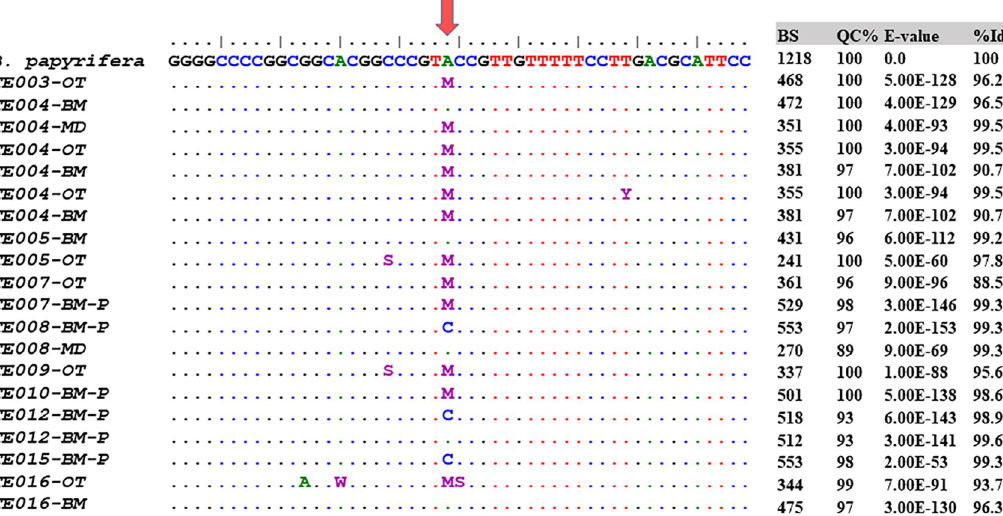
Fig 2. Polymorphisms detected in the ITS-1 sequence of paper mulberry barkcloth textiles. Multiple alignment of 20 selected partial ITS sequences (50 bp) of textile samples. Image adapted from Bioedit 7.1.3.0. The reverse sequence (with primer ITS-C) is shown. The red arrow indicates the polymorphic nucleotide at the relative position 203 [21]. HM623778 corresponds to the ID of the B . papyrifera ITS region published in Genbank. M = double signal A/C at this position. Y = C or T; S = C or G; W = A or T. Bite Score (BS), Query Coverage (QC), E-values and identity percentage (Id) are indicated on the right. Extension names OT = sample amplified at the University of Otago using KAPA HiFi Hot Start DNA Polymerase; BM = sample amplified using GoTaq 1 G2 DNA Polymerase at the Faculty of Chemical and Pharmaceutical Sciences, University of Chile; MD = sample amplified using GoTaq 1 G2 Hot Start Flexi DNA Polymerase at the Faculty of Medicine, University of Chile, and P = sample amplified after extract